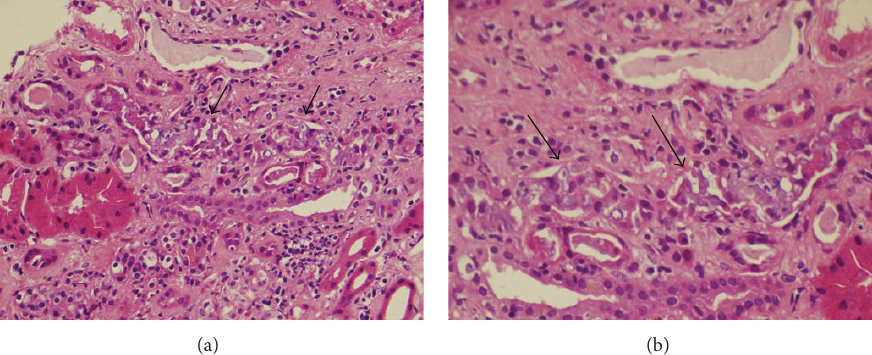
Figure 2: Case B renal allograft biopsy. Intratubular small fragments and hyphae of mucormycetes (by arrows) without extratubular invasion are noted by low magnification (a) and high magnification (b) on H&E staining